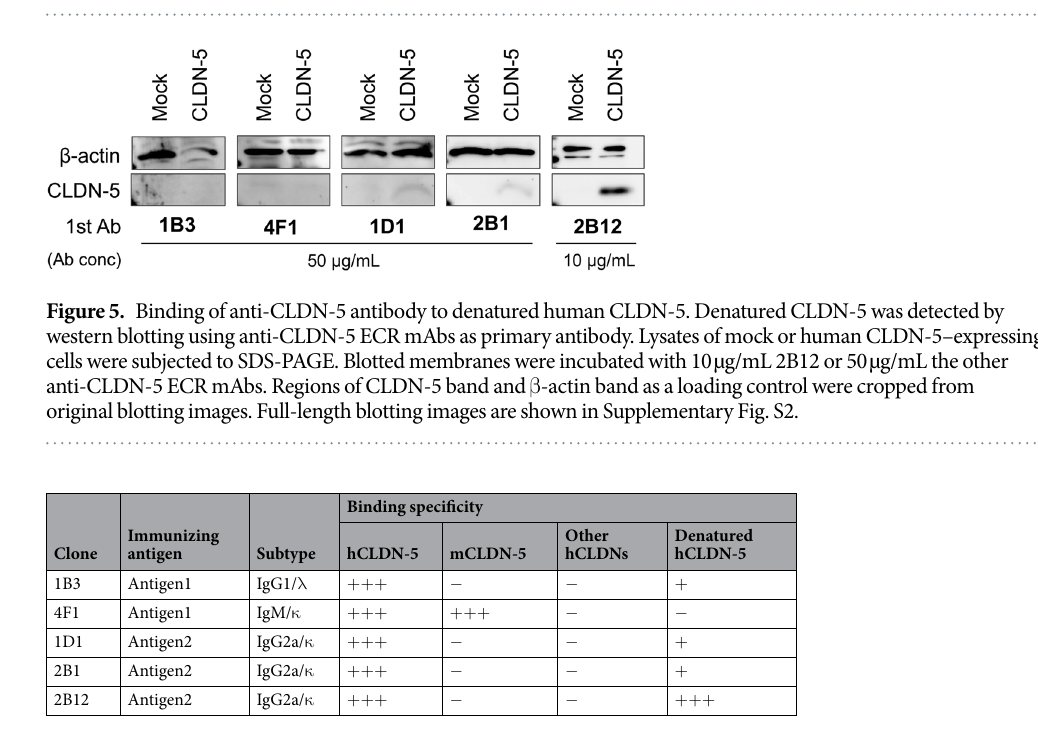
Figure 4. Subtype-specificity analyzed by ELISA with cell-free synthesized CLDN array. Twenty-seven human CLDNs were fused with AGIA tag and synthesized in liposomes by the wheat cell-free system. DRD1 was synthesized as a negative control. Cell-free synthesized proteoliposomes were immobilized on a micro titer plate, and binding between membrane protein and anti-CLDN-5 ECR mAb or anti-AGIA antibody was detected by ELISA.